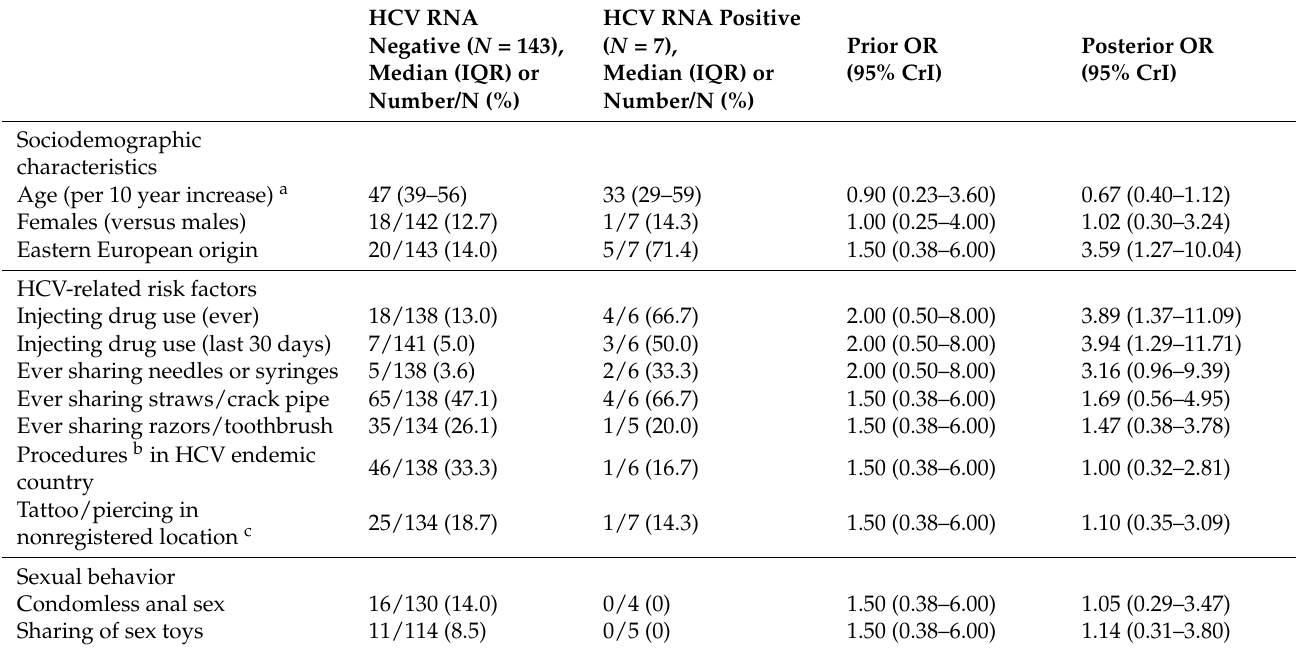
Table 2. Characteristics and risk behaviors according to hepatitis C virus (HCV) RNA status, and prior and posterior estimates of risk factors for HCV RNA positive